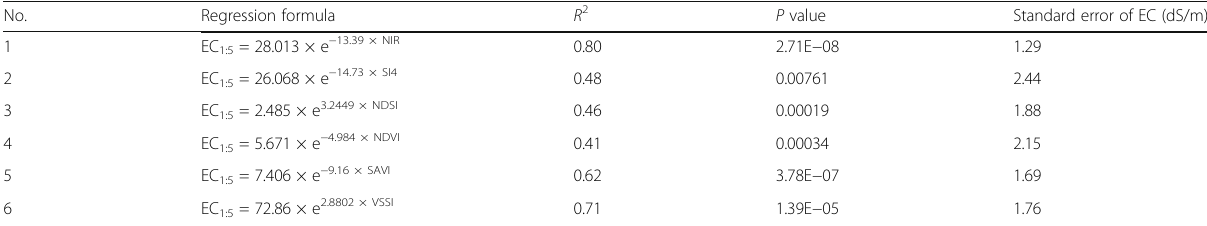
Table 3 Regression models for estimating EC from remote sensing data No. Regression formula R